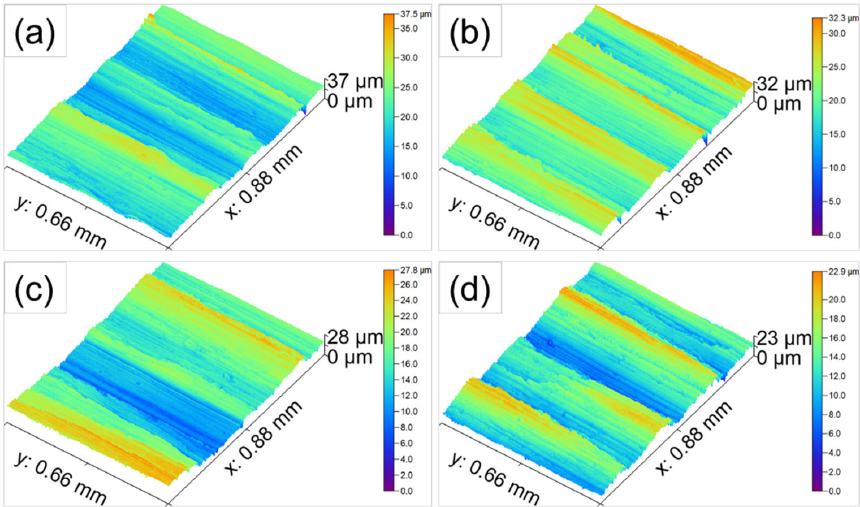
Figure 7. Surface topography of the machined surface using UCI: ( a ) CT; ( b ) 0.42 A/mm 2 ; ( c ) 0.57 A/mm 2 ; and ( d ) 0.90 A/mm 2 .